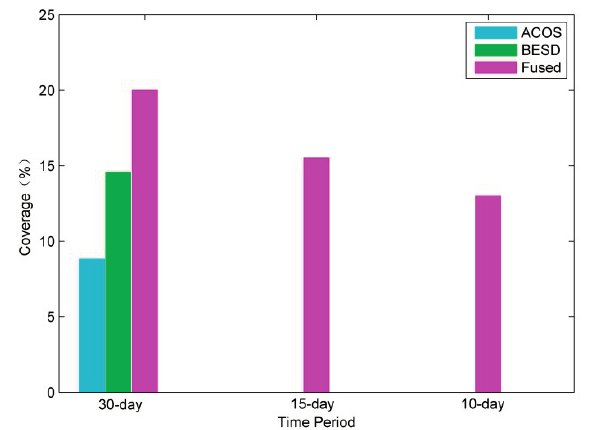
Figure 2. Global land coverage percentage of XCO data within 1° × 1° grids for October 2010.